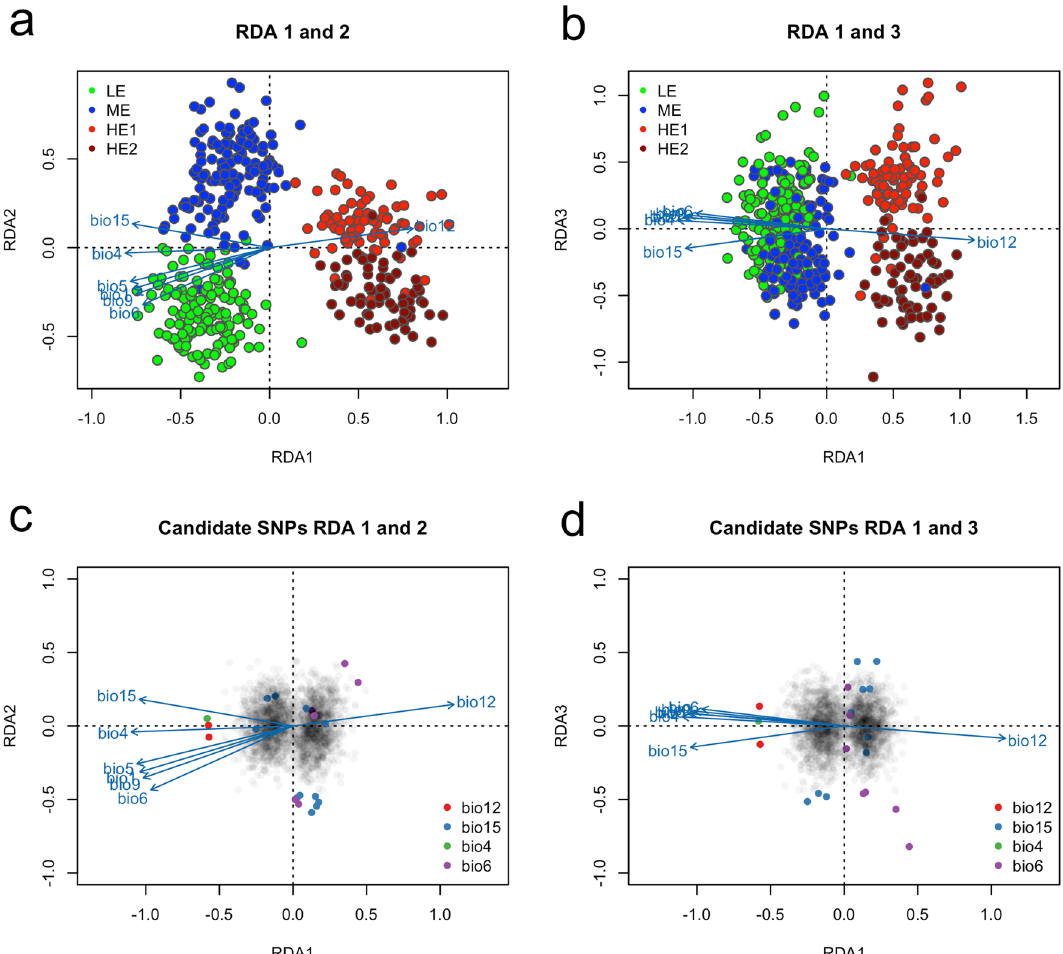
Figure 6. ( a , b ) Individuals plotted by their score on the first, second, and third significant axes ( a ) RDA1 and RDA2; b: RDA1 and RDA3), population indicated by color; ( c , d ) 1916 SNPs plotted by their score on the first, second, and third significant axes ( c ) RDA1 and RDA2; ( d ) RDA1 and RDA3. Significant outlier SNPs (n = 20) are colored according to their most correlated climate variable (bio4 = temperature seasonality, bio6 = min temperature of coldest month; bio12 = annual precipitation, bio15 = precipitation